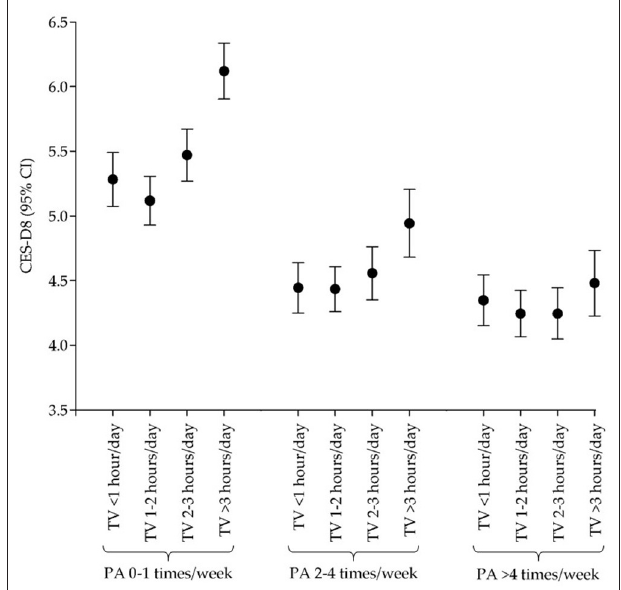
FIGURE 1 | Relationship across physical activity, TV watching, and depressive symptoms in men.